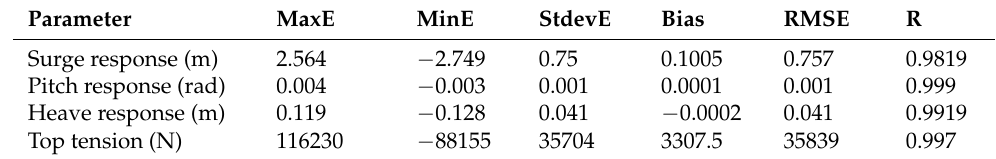
Table 8. Results predicted by ANN and FEM in a statistical comparison of Spar mooring responses. Parameter